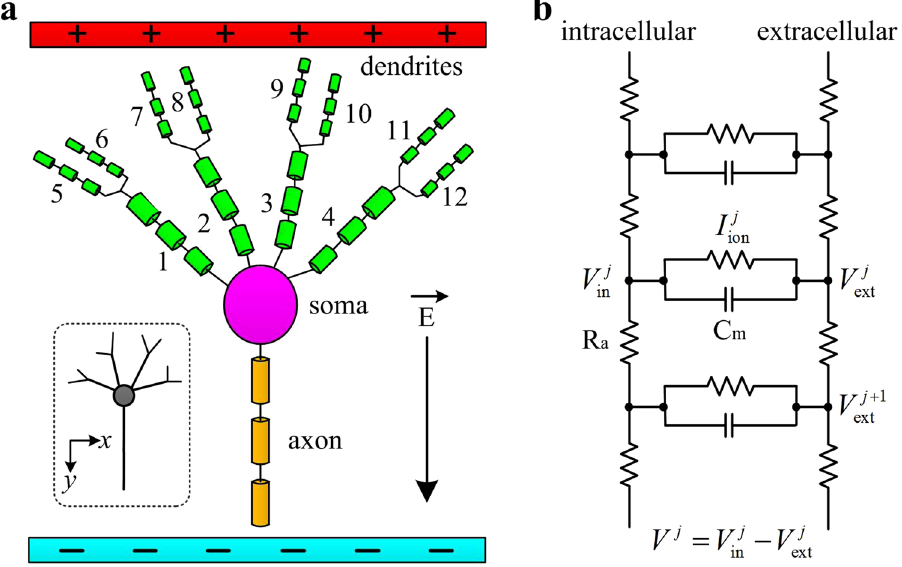
Figure 9. Artificial pyramidal neuron. ( a ) Schematic diagram of the multi-compartment artificial model stimulated by uniform EF parallel to the somato-dendritic axis (i.e., y axis). Positive EF is created by placing a negative electrode close to the axon and a positive electrode close to the dendrites. ( b ) Circuit representation of the active